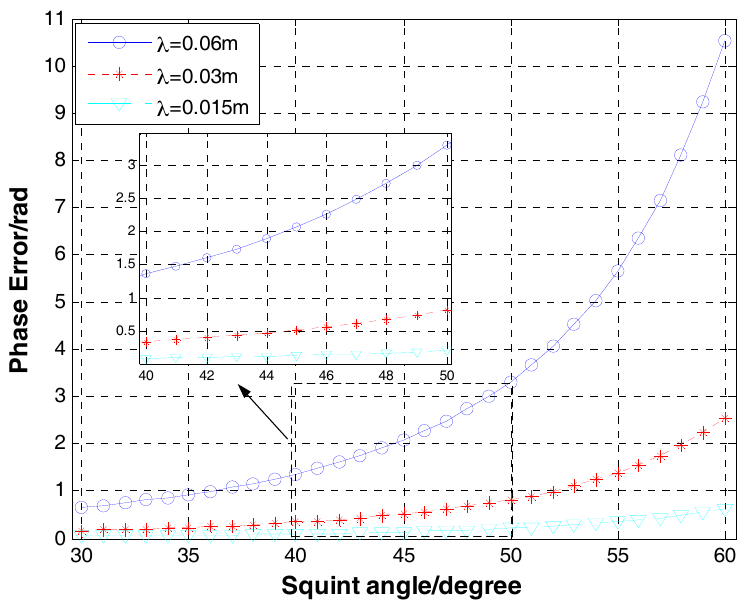
Figure 7. Phase error of targets in the edge (the distance departing from the referenced azimuth position is 2 km and the squint angle is 45°) varies with the azimuth resolution and wavelength. The blue solid line with ‘o’, the red dash line with ‘*’ and the cyan lineation line with ‘  ’ are the results with the wavelength equaling to 0.06 m, 0.03 m and 0.015 m, respectively.